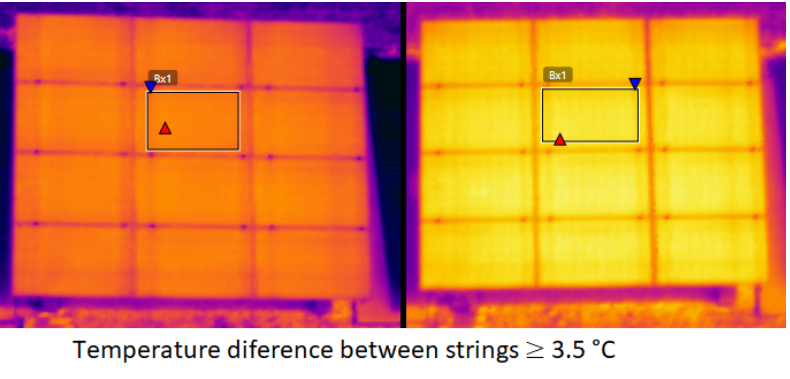
Figure 11. IR images analyzed for case 30. String 2 ( left ) and string 4 ( right ). In this case, the short circuit to earth caused the inverter to open the circuit (electrical protection), causing an increase in the temperature of the entire